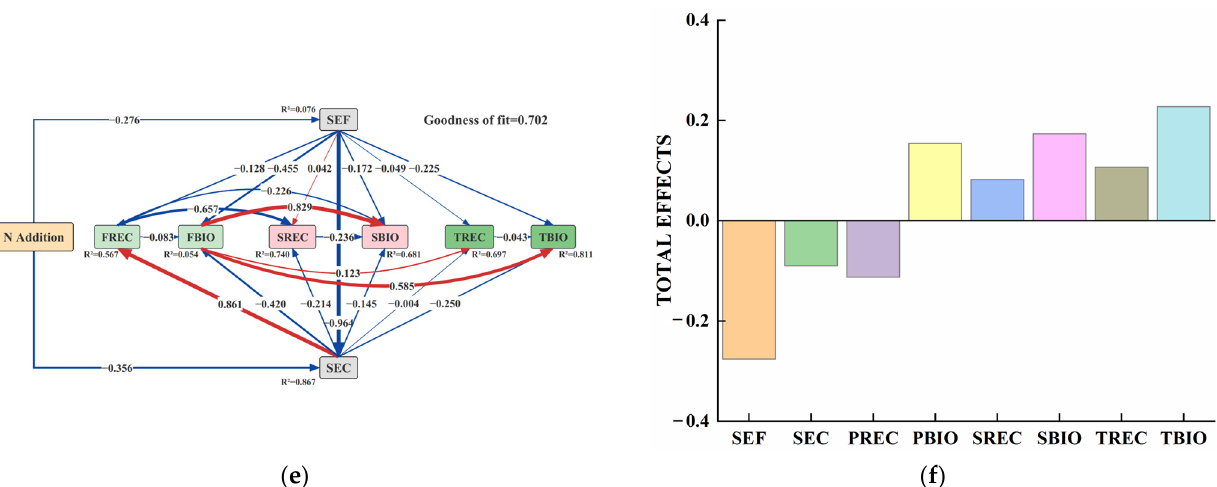
Figure 6. PLS model of the fine-root–soil stoichiometry of Picea schrenkiana with different root se- quences at the level of the mixed organic–inorganic nitrogen source inputs in the Tianshan Mountains, Xinjiang. ( a ) shows the stoichiometric PLS model of fine-root soil of Picea schrenkiana at the organic nitrogen input level; ( b ) is the overall impact histogram of the fine-root soil stoichiometric PLS model of Picea schrenkiana at different nitrogen input levels; ( c ) shows the stoichiometric PLS model of the fine-root soil of Picea schrenkiana at inorganic nitrogen input levels; ( d ) is the overall impact histogram of the fine-root soil stoichiometric PLS model of Picea schrenkiana at different nitrogen input levels; ( e ) shows the stoichiometric PLS model of fine-root soil of Picea schrenkiana at the mixed organic–inorganic nitrogen source level; and ( f ) shows the overall impact histogram of the fine-root soil stoichiometric PLS model of Picea schrenkiana under different nitrogen input levels. The red arrow represents a positive correlation, and the blue arrow represents a negative correla- tion. N addition denotes the nitrogen source, SEC is the soil ecological stoichiometry, SEF is the soil environmental factor, FRTN is the first-order fine-root ecological stoichiometry, FBIO is the first- order fine-root biomass, SRTN is the second-order fine-root ecological stoichiometry, SBIO is the second-order fine-root biomass, TRTN is the third-order fine-root ecological stoichiometry, and TBIO is the third-order fine-root biomass.